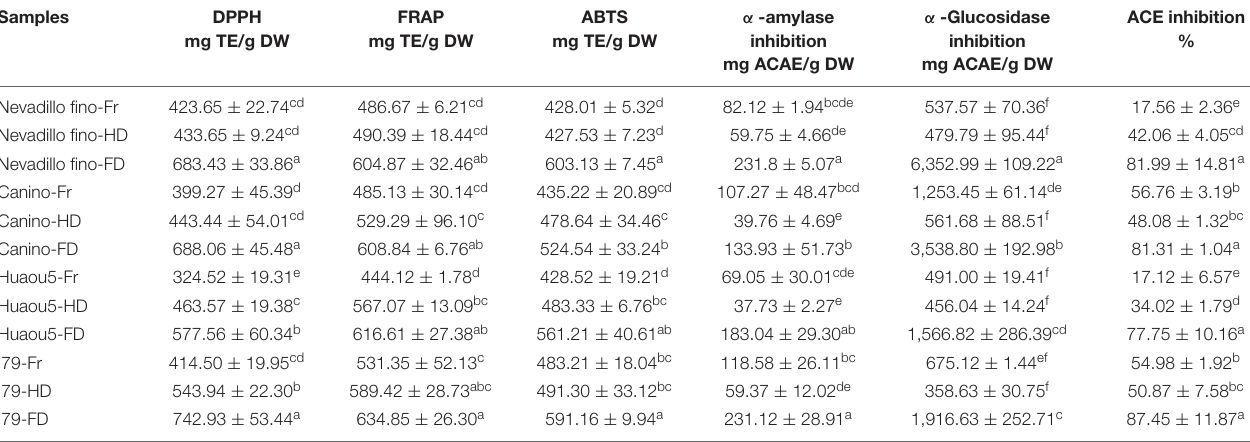
TABLE 4 | Antioxidant, α -amylase, α -glucosidase, and ACE inhibition activities of the olive leaves.